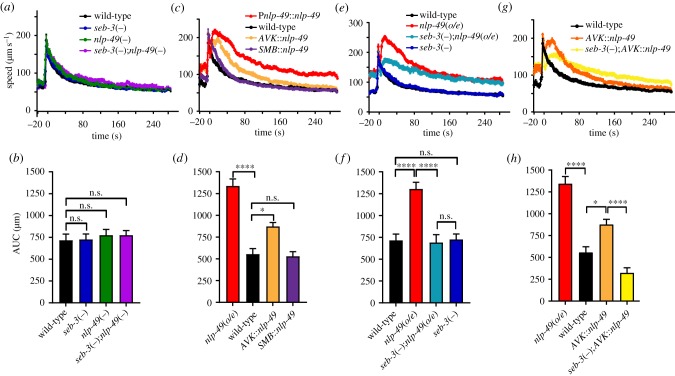
nlp-49 and seb-3 promote locomotor arousal. seb-3(tm1848) is referred to as seb-3(−) and nlp-49(gk546875) as nlp-49(−). Tap stimulation is provided at t = 0. (a) Speed traces of nlp-49(−) and seb-3(−) single mutants, and seb-3(−);nlp-49(−) double mutants, together with wild-type controls following tap. (b) Quantification of locomotor arousal responses for (a) showing the area under the curve for 10–24 s post-tap. (c) Speed traces of transgenic animals overexpressing nlp-49 using its own promoter (nlp-49(o/e)), or specifically in the SMB (using the flp-12 promoter) [38] or AVK (using the flp-1 promoter) [39] neurons following tap. (d) Quantification of arousal responses for (c). (e) Speed traces of animals overexpressing nlp-49 from its own promoter, with or without the mutant allele for seb-3 (seb-3(−)), together with wild-type and seb-3(−) controls following tap. (f) Quantification of arousal responses in (e). (g) Speed traces of animals overexpressing nlp-49 from the AVK neurons, with or without the mutant allele for seb-3, together with wild-type controls following tap. (h) Quantification of arousal responses in (g). nlp-49(o/e) is shown for comparison. n > 200 for all genotypes. Error bars indicate mean ± s.e.m. Statistical tests: one-way ANOVA, Sidak's post-test. p-values indicated by n.s., not significant, * < 0.05 and **** < 0.0001.